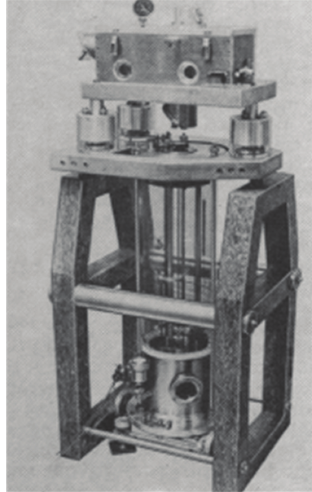
Figure 4: The IMGC absolute gravity meter.